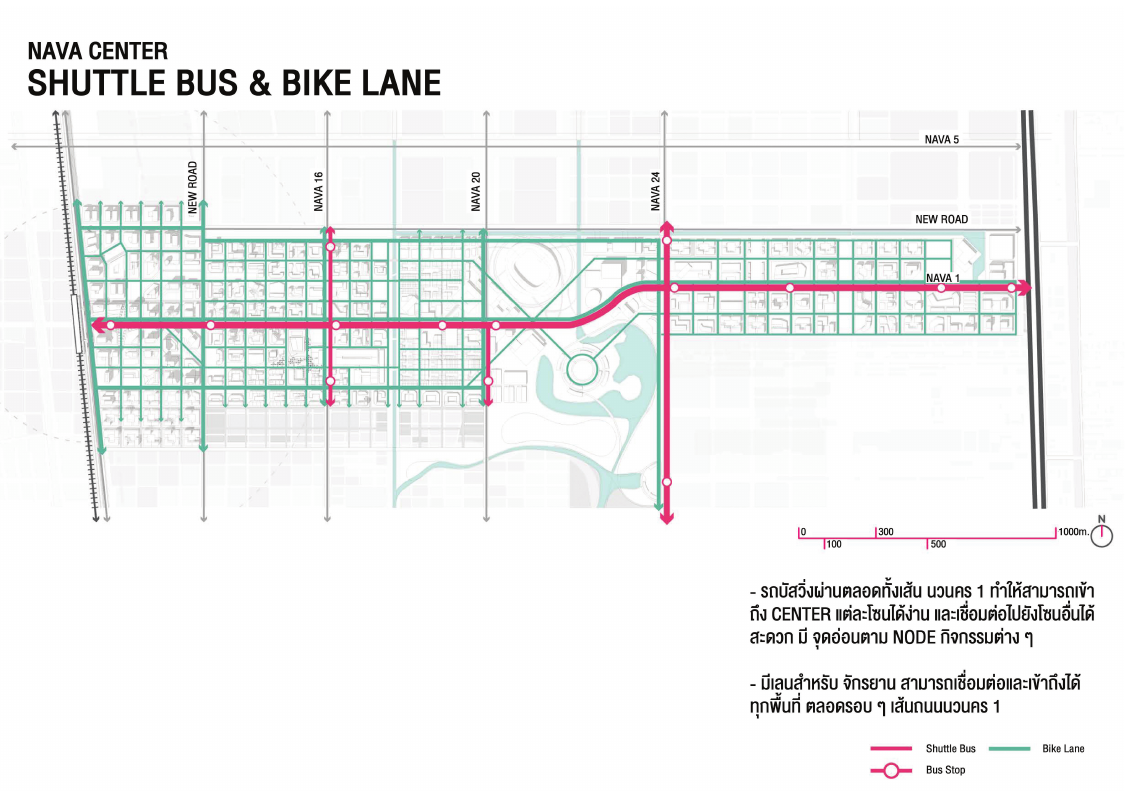
Figure 9. Shuttle-bus network and dedicated bike paths connecting the SRT red line extension terminus with the heartland of Nava Nakorn. Graphics credits to Thanakit Singduang, Thanyamon Traimittaparp, Areerat Joemkor, Kotchakorn Chaiyatum, Apicha Promnao, Thannicha Charoenwan, Thanawit Likhitworasak, Phatharamon Panon, Nanthicha Jiwatjanarodom, AR416